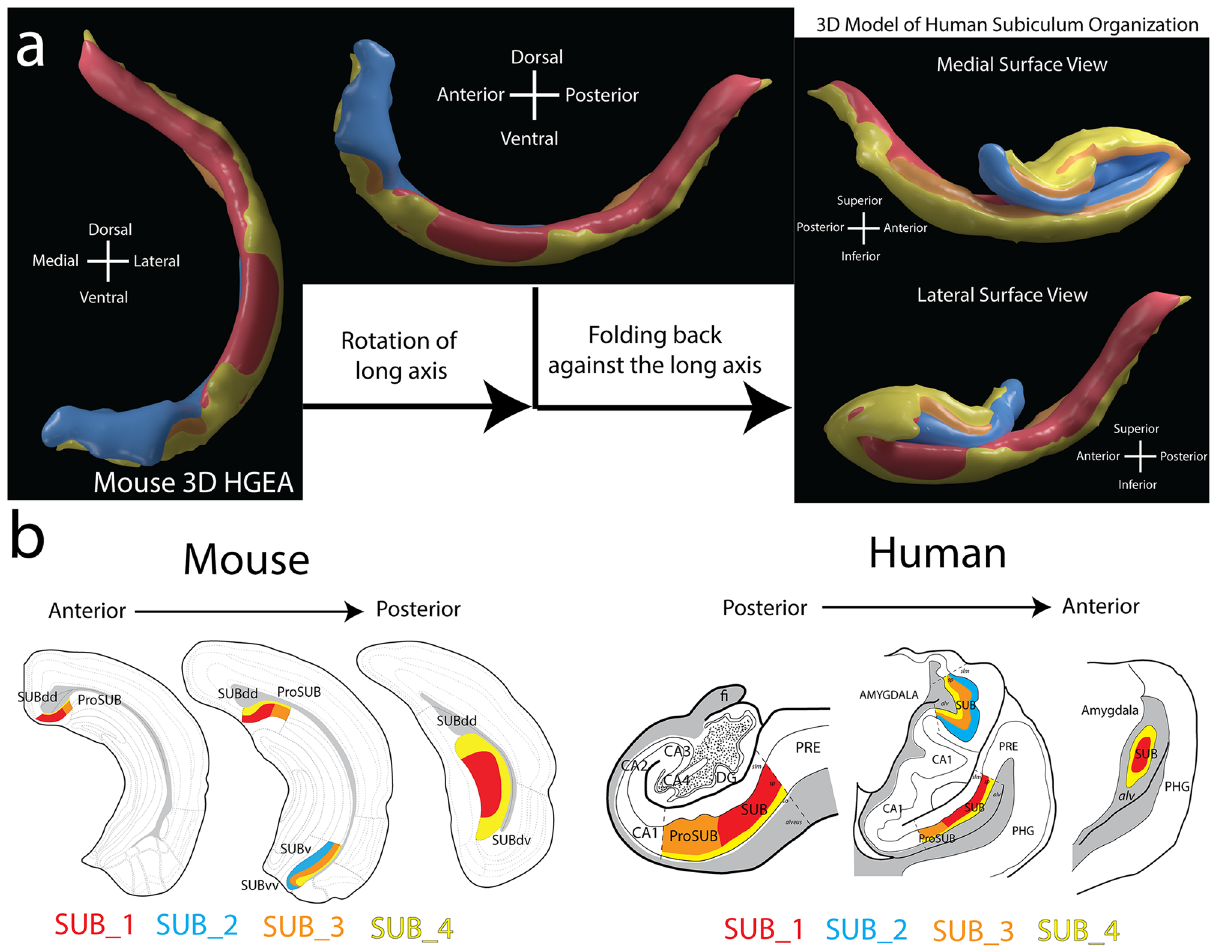
Figure 8. A 3D translational model of mouse and human SUB laminar organization. ( a ) Using the 3D HGEA model of the mouse SUB (left), we developed a 3D model of the human SUB based on our observations of the gene expression-based SUB lamina and the relative position of corresponding SUB subregions. Our model suggests two changes to the SUB have occurred across evolution between the mouse and human: 1) rotation of the longitudinal axis (middle), and 2) the folding back of the anterior SUB against the long axis (right). Images on the right show the view of the human SUB model from the medial (top) or lateral perspective (bottom; see also Supplementary Movie 2 or use Schol-AR app). ( b ) Coronal atlas section series from the mouse HGEA with the 4 colored gene expression layers and subregions (left) with similarly corresponding coronal human atlas drawings with similarly colored gene expression layers and subregions (right). Data viewable with Schol-AR augmented reality app, for details visit https ://www.ini.usc.edu/schol ar/downl